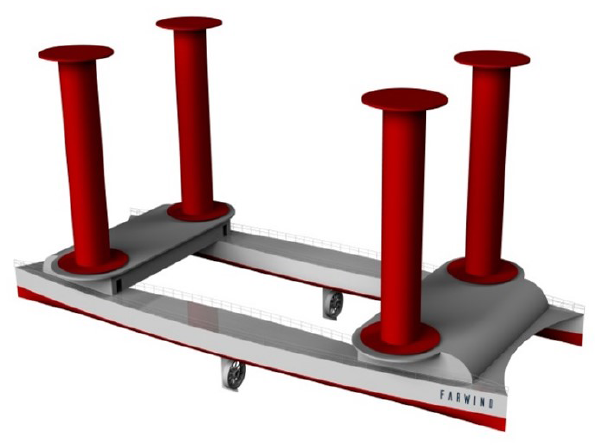
Figure 2. Artist’s view of the proposed energy ship